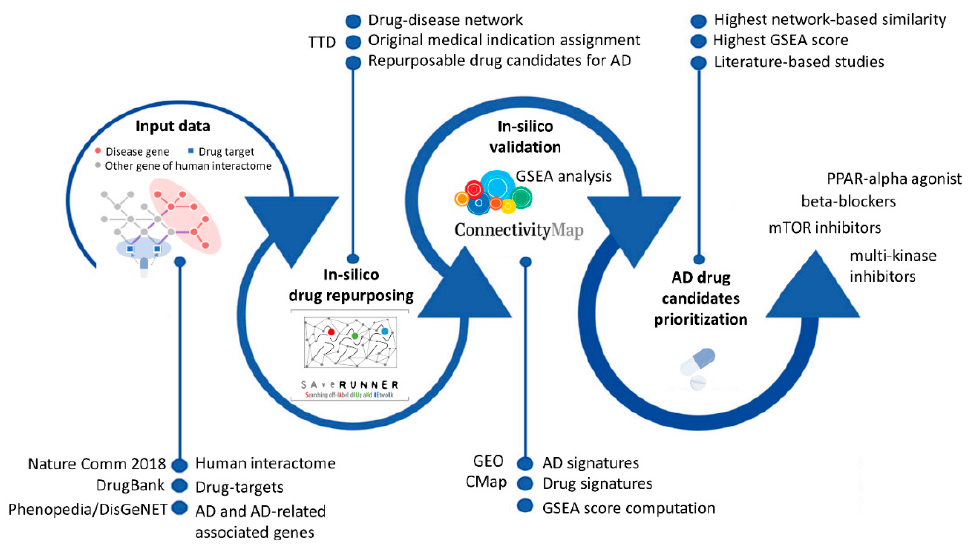
Figure 1. Workflow of the study. The input data are: (i) the human interactome download from [6], (ii) a list of drug targets acquired from DrugBank [19]; (iii) a list of disease-associated genes for Alzheimer’s disease (AD) and other diseases related to AD acquired from the Phenopedia [20] and DisGeNET [21] data sources. First, an in silico drug repurposing analysis was performed by using the SAveRUNNER algorithm to obtain candidate drugs for the understudied diseases. SAveRUNNER releases the drug-disease network, where the nodes are drugs and diseases, and a link occurs between them if the drug–disease association has been found to be statically significant and the weight of their association is the network-based similarity measure. Then, the original medical indications are retrieved from Therapeutic Target Database (TTD) and are assigned to each predicted drug. Looking at the drugs predicted by SAveRUNNER for AD, an in silico validation based on the gene set enrichment analysis (GSEA) has been performed by assigning a score that reflects the possible counteraction of the predicted drugs (drug signatures acquired from Connectivity Map—CMap [22,23]) on the AD pathophenotype (disease signatures acquired from the Gene Expression Omnibus—GEO [24]).